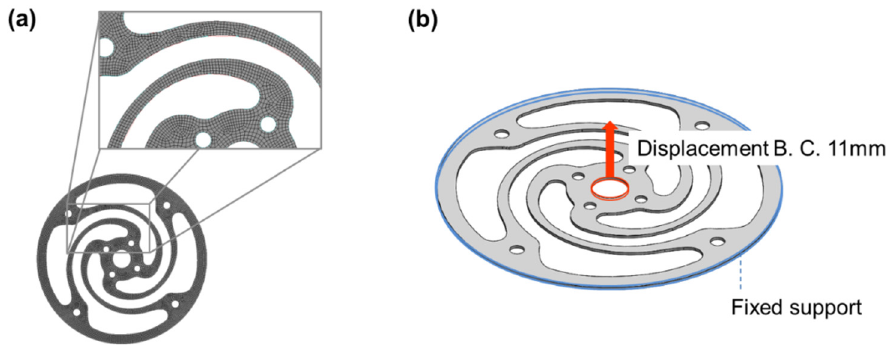
Figure 9. Simulation model of the flat spiral spring: ( a ) mesh of spring for FEM, and ( b ) boundary condition of spring for FEM.